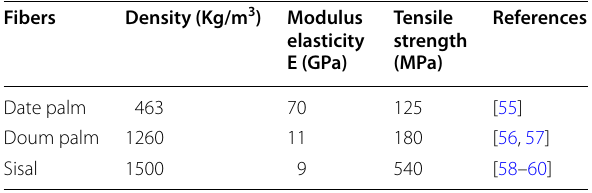
Table 1 The different mechanical properties of the fibers used in genetic simulation Fibers